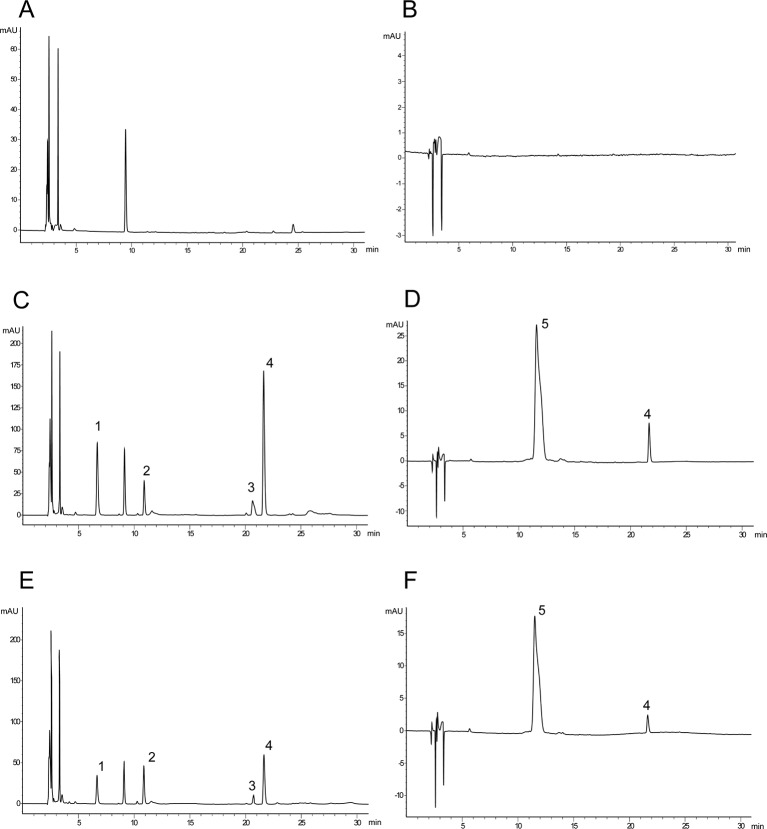
Typical chromatograms of rat plasma. (A) Blank serum sample (280 nm); (B) blank serum sample (403 nm); (C) blank serum sample spiked with danshensu (DSS), hydroxysafflor yellow A (HSYA), salvianolic acid B (SAB), salvianolic acid A (SAA), and internal standard (IS) (280 nm); (D) blank serum sample spiked with HSYA and p-hydroxybenzoic acid (403 nm); (E) after 10 minutes of administration (280 nm); (F) after 10 minutes of administration (403 nm) (1: DSS; 2: p-hydroxybenzoic acid (IS); 3: SAB; 4: SAA; 5: HSYA).